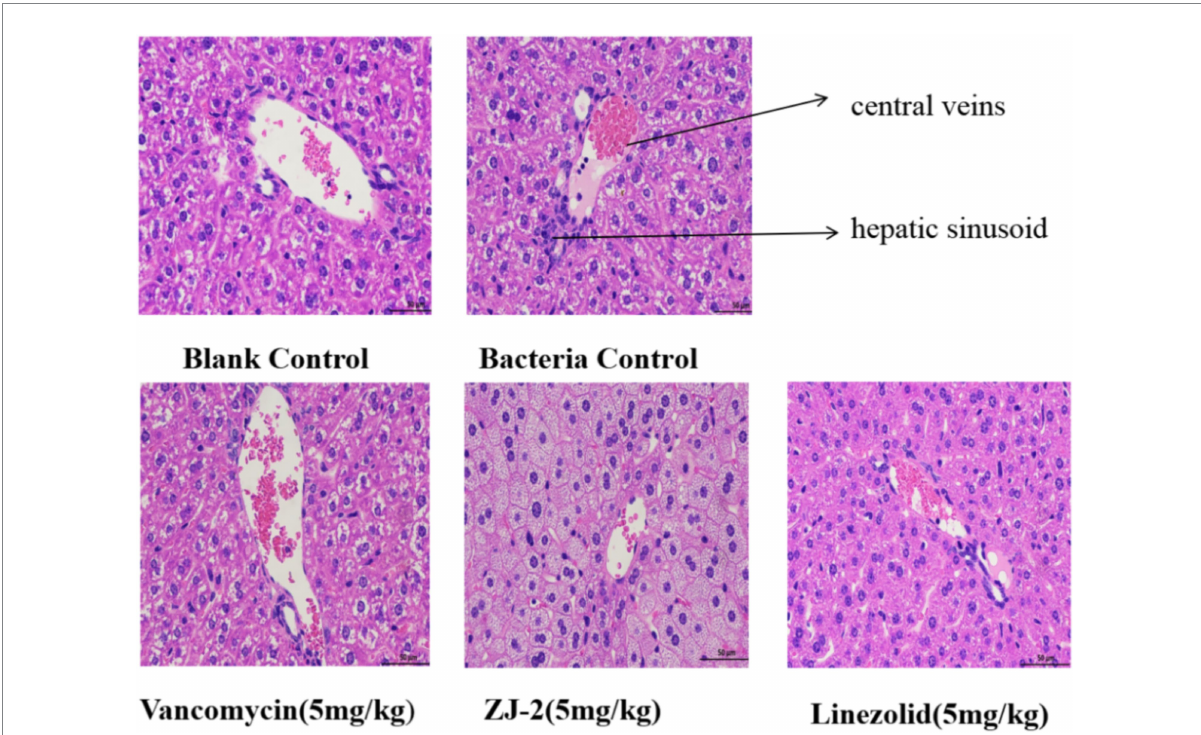
FIGURE 10 Liver histology stained with H&E. The effect of ZJ-2 on the pathological changes of liver tissue was caused by E. faecium E3101. HE staining’s view is 50 μ